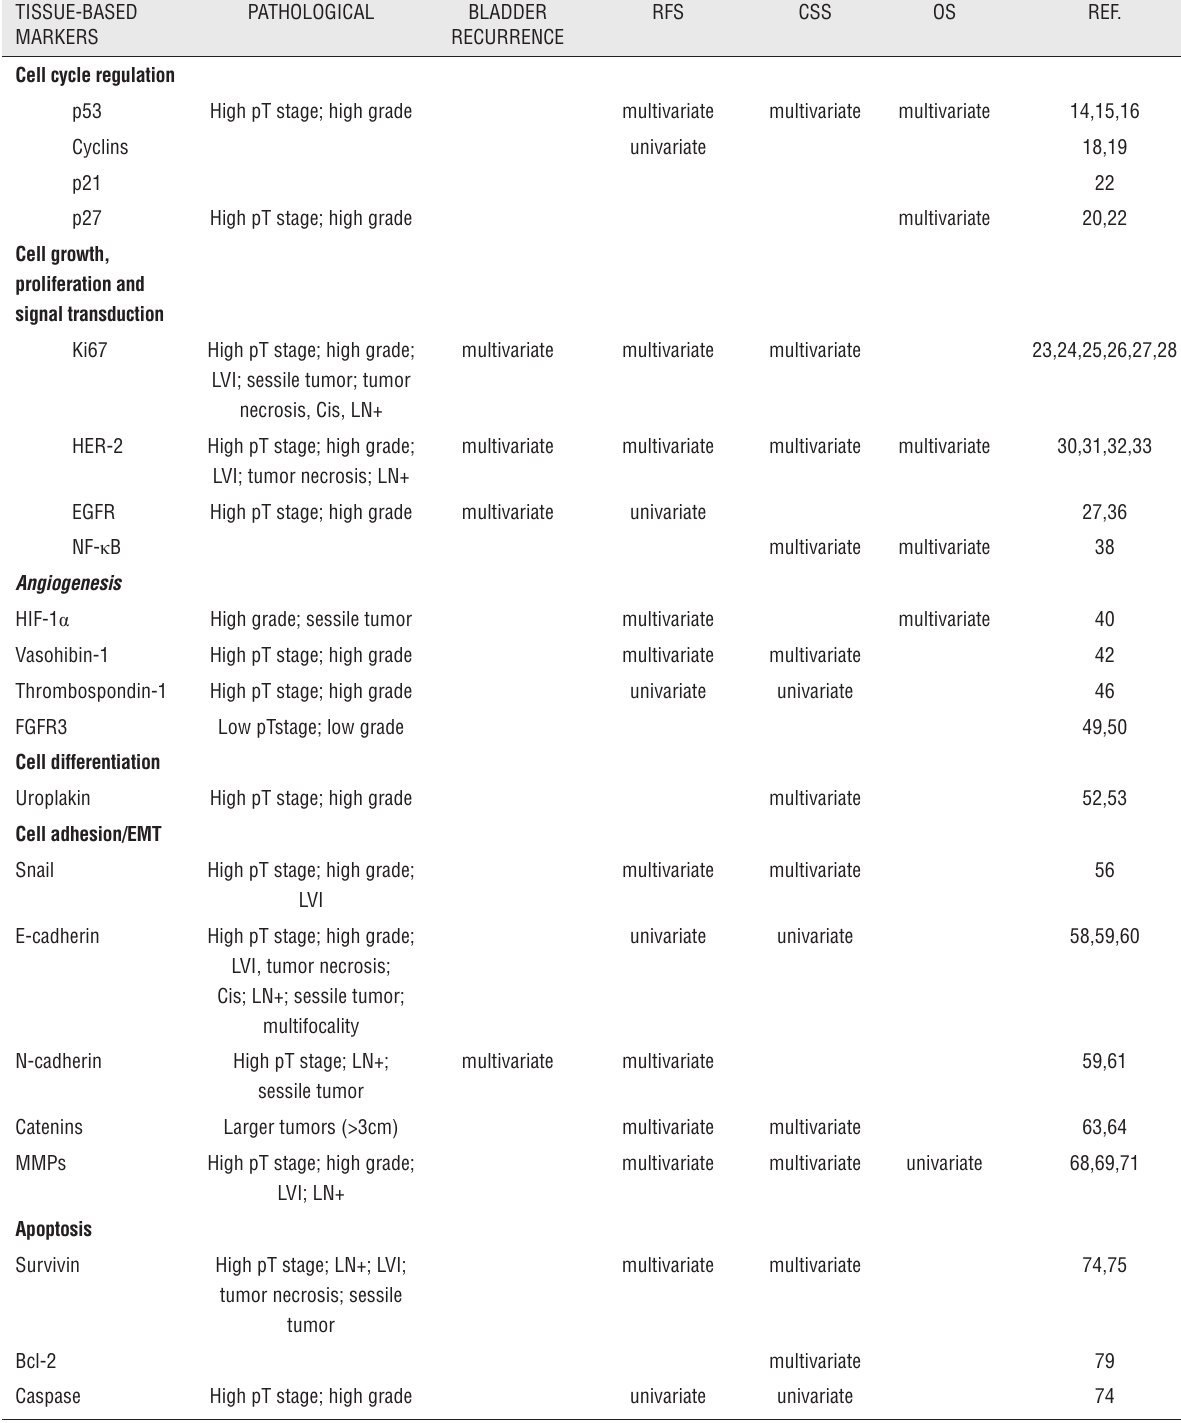
Table 2 – Tissue-based markers in upper tract urothelial carcinoma and their prognostic implications. TISSUE-BASED PATHOLOGICAL BLADDER RFS CSS OS MARKERS RECURRENCE